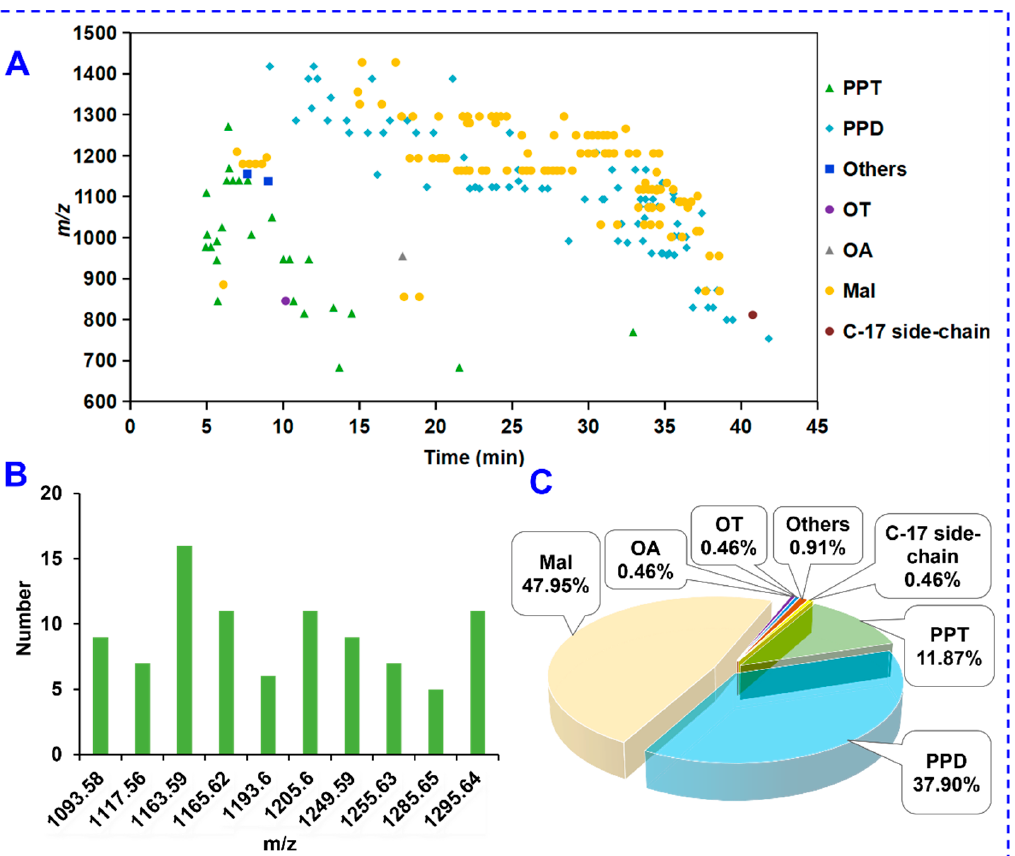
Figure 4. Summary on the ginsenosides characterized from PNF: ( A ) a two-dimensional scatter plot by t R and m/z showing the relationship between the retention time and molecular mass; ( B ): a bar chart showing the numbers of typical ginsenoside isomers; ( C ): a pie chart sorted by the ginseno- side